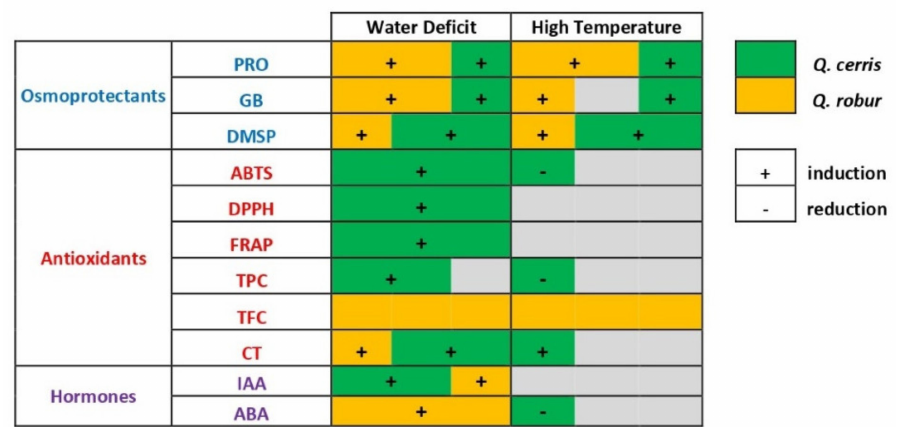
Figure 9. Schematic representation of the soil-water-deficit and high-air-temperatures-induced changes in leaf level content of osmoprotectants, antioxidants, and hormones in Q. cerris and Q. robur . The size of the boxes reflects the relative induction or reduction of one species compared with the other. See legend of Figure 6 for abbreviations of the